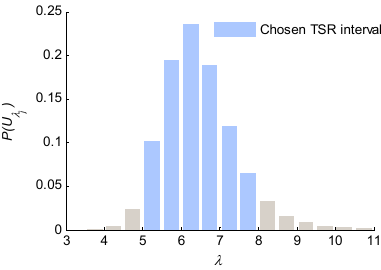
Figure 4. The proportion of the inflow wind energy corresponding to different tip speed ratio (TSR) intervals.